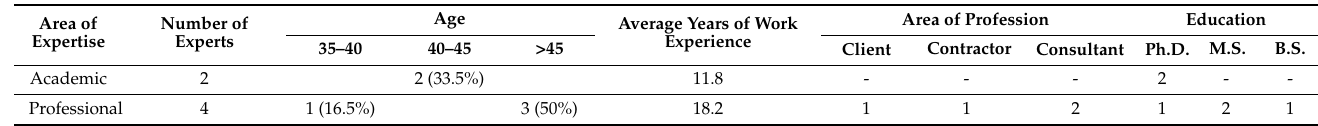
Table 4. Descriptive data and demography of the selected